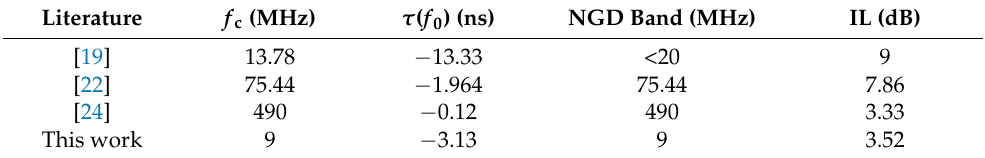
Table 8. Performance comparison between low-pass negative group delay and reported NGD